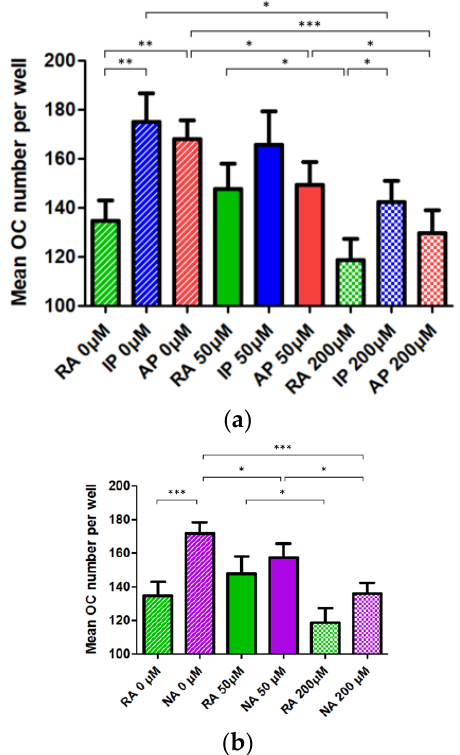
Figure 3. Impact of genotype and cysteamine treatment on osteoclast differentiation in patients with nephropathic cystinosis, ( a ) when analyzing the three genotypes independently, and ( b ) when combining the inactive and absent protein. Osteoclasts (TRAP-positive cells with over three nuclei) were generated from PBMCs of cystinotic patients, and treated with increasing doses of cysteamine (untreated, 50 and 200 µM). Results in terms of osteoclasts number are presented as means for seven to eight wells, with SEM. A total of 11 patients were included in the analysis, as data on genotype were not available for two of the 13 patients whose cultures developed properly. RA, residual activity; IP, inactive protein; AP, absent protein; NA: inactive or absent protein. OC, osteoclasts; TRAP, Tartrate-Resistant Acid Phosphatase; PBMC, Peripheral Blood Mononuclear Cells; SEM, Standard Error of the Mean. * p < 0.05, ** p < 0.01 and *** p < 0.001 compared between indicated groups.